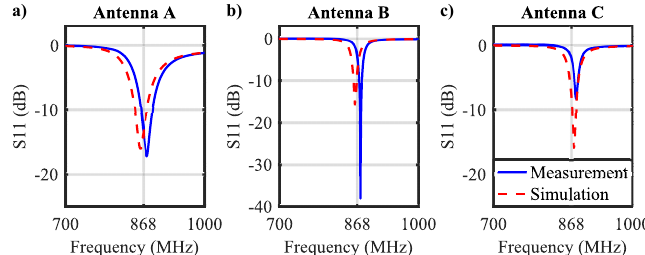
Figure 4. Reflection coefficient plots of the manufactured antennas from the simulations shown in Figure 3.